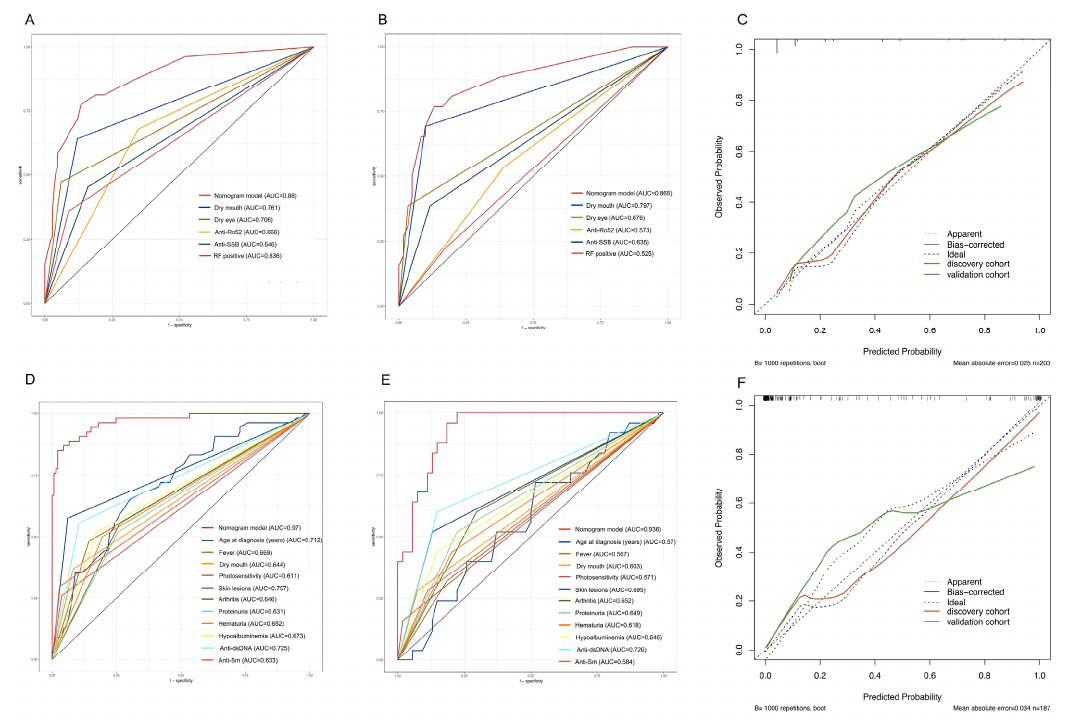
Figure 4. SLE-SS of predictive tool evaluation in SLE or SS patients. ( A , B ) ROC curves of SLE in SLE-SS based prediction tools in the discovery and validation cohorts, respectively. ( D , E ) ROC curves of SS in SLE-SS-based prediction tools in the discovery and validation cohorts, respectively. ( C , F ) Calibration plots for predicting SLE or SS in SLE-SS patients.